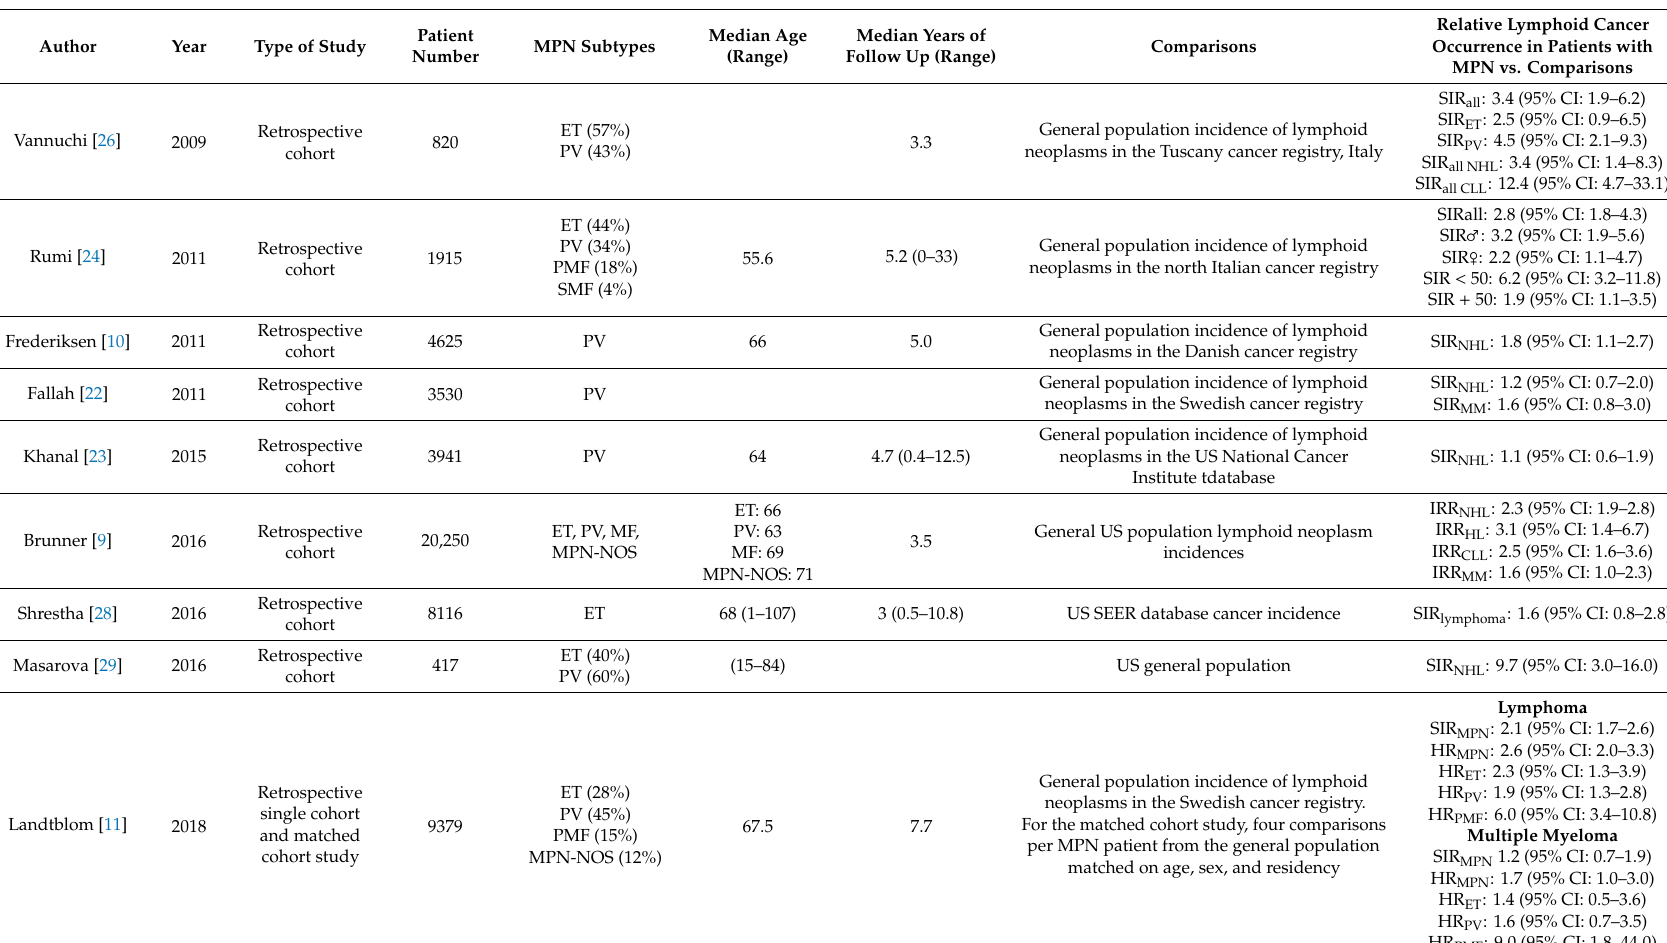
Table 2. Studies on incidence of malignant lymphoid neoplasms in patients with chronic myeloproliferative neoplasms (MPNs) compared to cancer incidence in the general population or matched comparisons.